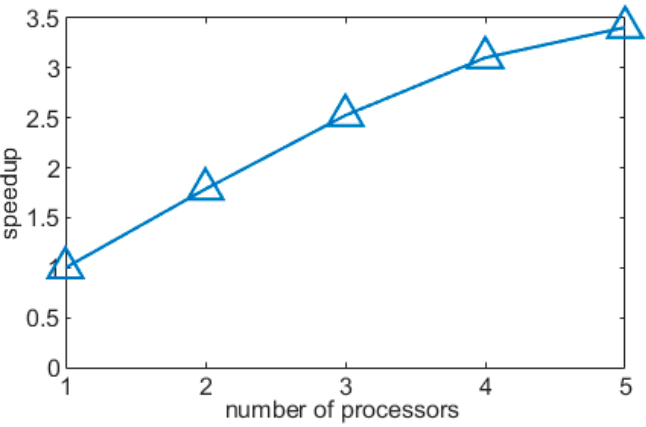
Figure 5. Speedup of satellite orbit determination with multi-process parallel computing.